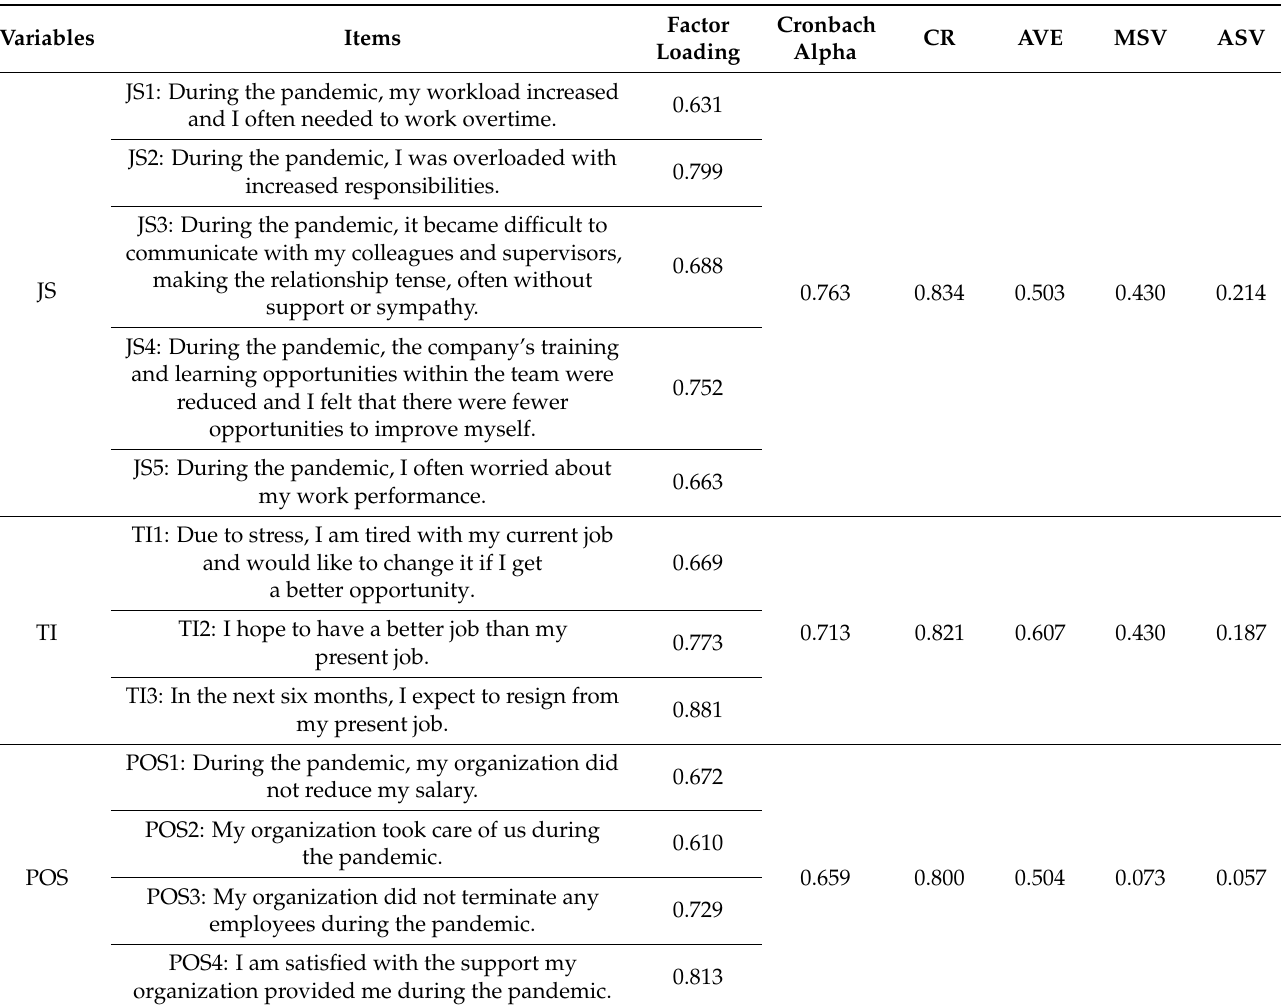
Table 2. The reliability and validity analysis of the measured